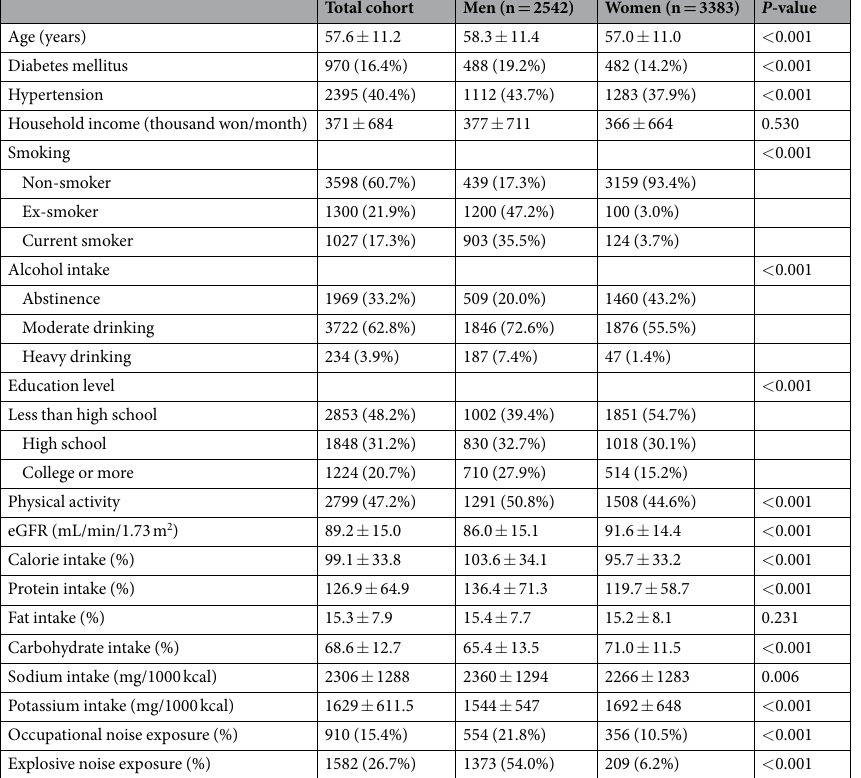
Table 1. Clinical characteristics of participants according to sex. The data are expressed as numbers (percentages) for categorical variables and means ± standard deviations for continuous variables. The differences between men and women were tested using t -tests for continuous variables and Pearson’s χ 2 test or the Fisher’s exact test for categorical variables. Abbreviation: eGFR, estimated glomerular filtration